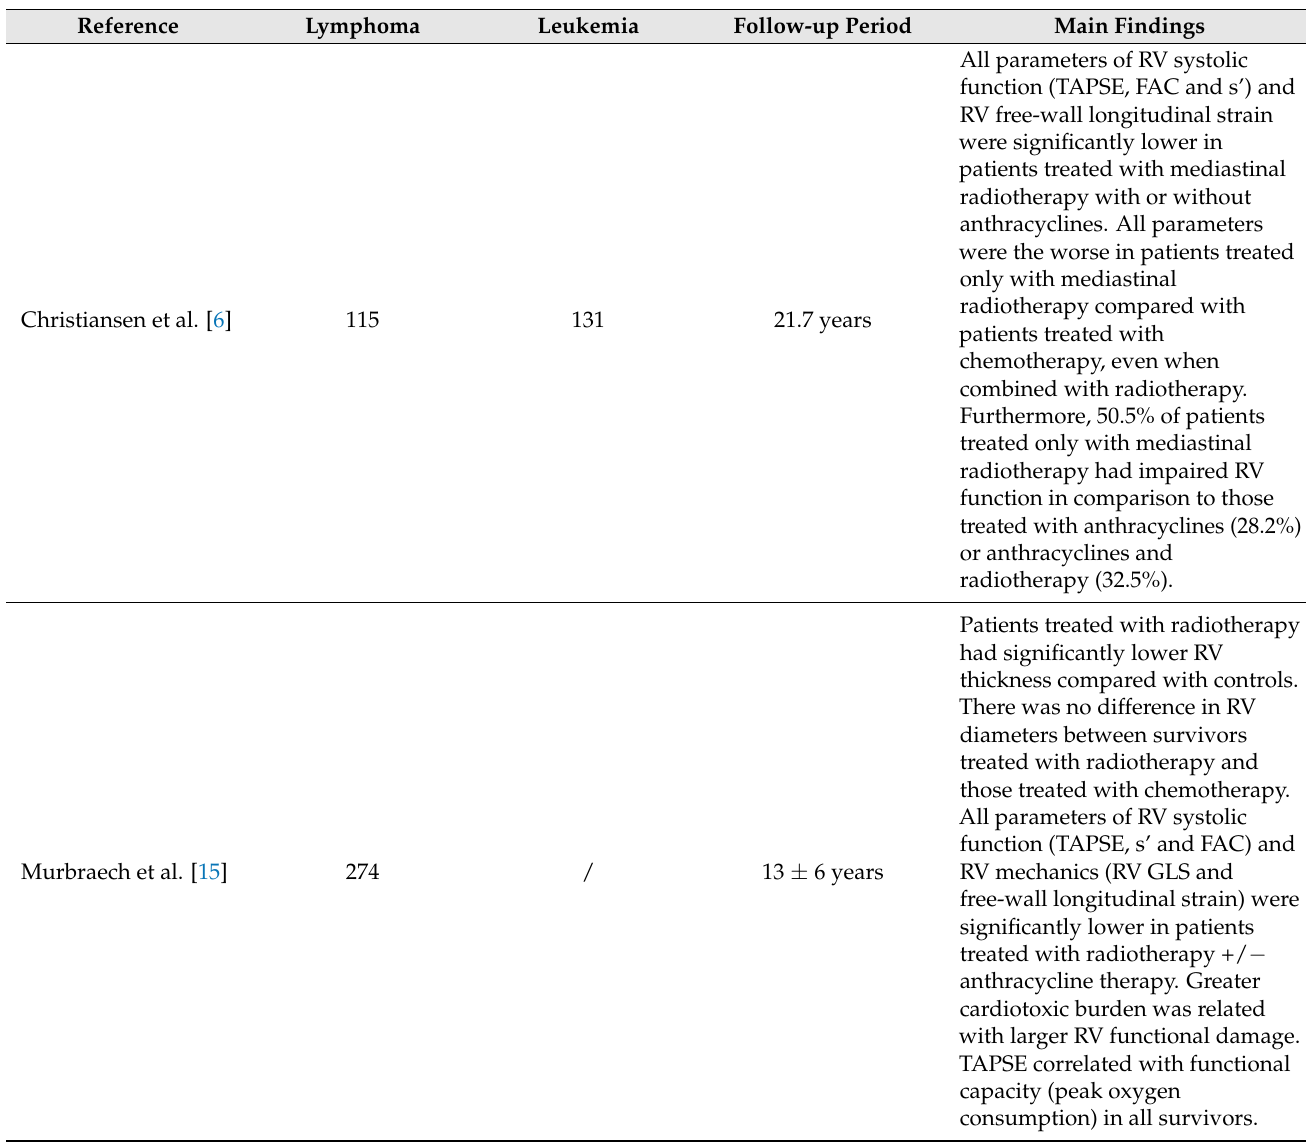
Table 2. RV remodeling in survivors with hematological malignancies who received